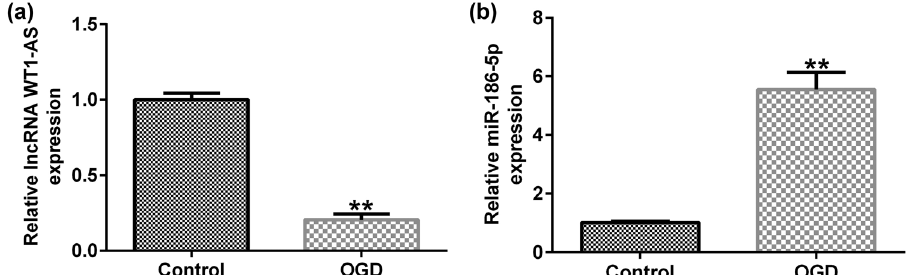
Figure 2: Expression levels of lncRNA WT1 - AS/miR - 186 - 5p in OGD - induced SH - SY5Y cells. ( a ) RT - qPCR analysis results showing lncRNA WT1 - AS expression levels. ( b ) RT - qPCR analysis results showing miR - 186 - 5p expression levels. ** P < 0.01 vs control group. GraphPad Prism 6.0 software ( GraphPad Software, Inc. ) was used for creation of the fi